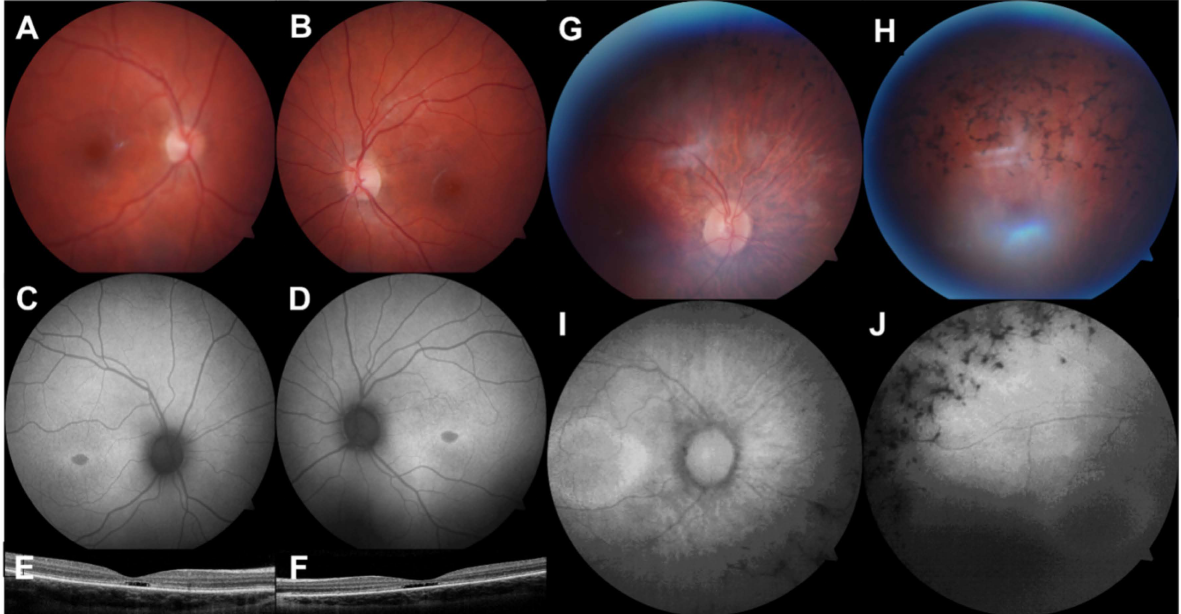
Figure 1. Multimodal retinal imaging of 2 paediatric IRD cases. ( A , B ). Colour fundus photographs (FF450 plus, Carl Zeiss MediTec, Dublin, CA, USA) showing an altered foveal reflex. ( C , D ). Fundus autofluorescence images showing symmetrical hypoautofluorescence at the fovea with a hyperaut- ofluorescent margin. ( E , F ). Optical coherence tomography (iVue 80, Optovue Inc., Fremont, CA, USA) showing outer retinal cavitation at the fovea. This 13-year-old female had Stargardt disease due to compound heterozygous pathogenic ABCA4 variants. ( G , H ). Colour fundus photographs of the right eye showing optic nerve head pallor, arteriolar attenuation, and intraretinal pigment migration. ( I , J ). Fundus autofluorescence showing a hyperautofluorescent macular ring and peripheral hy- poautofluorescence. This 10-year-old female had autosomal dominant RP due to a likely pathogenic PRPF8